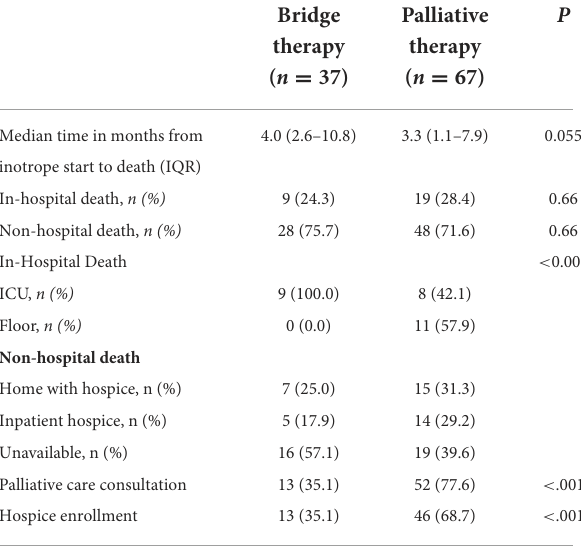
TABLE 2 Time from inotrope start to death, location of death, palliative care consultation, and hospice referral stratified by